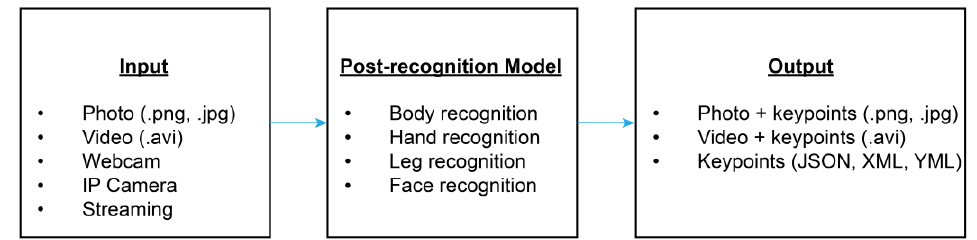
Figure 2. Flow of the OpenPose gesture recognition system.